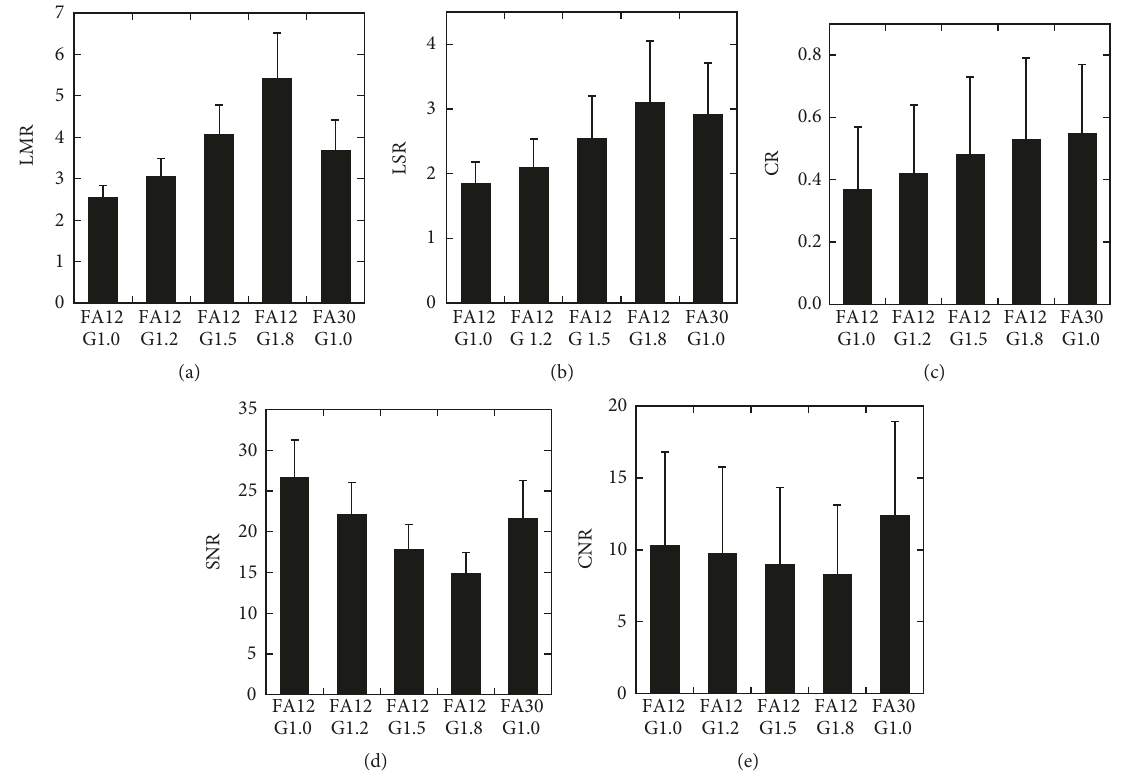
Figure 3: Results of quantitative indices: LMR (a), LSR (b), CR (c), SNR (d), and CNR (e). Error bars indicate SDs. FA12 and FA30 represent FAs of 12 ∘ and 30 ∘ , respectively. G1.0, G1.2, G1.5, and G1.8 represent the gamma values of 1.0, 1.2, 1.5, and 1.8,